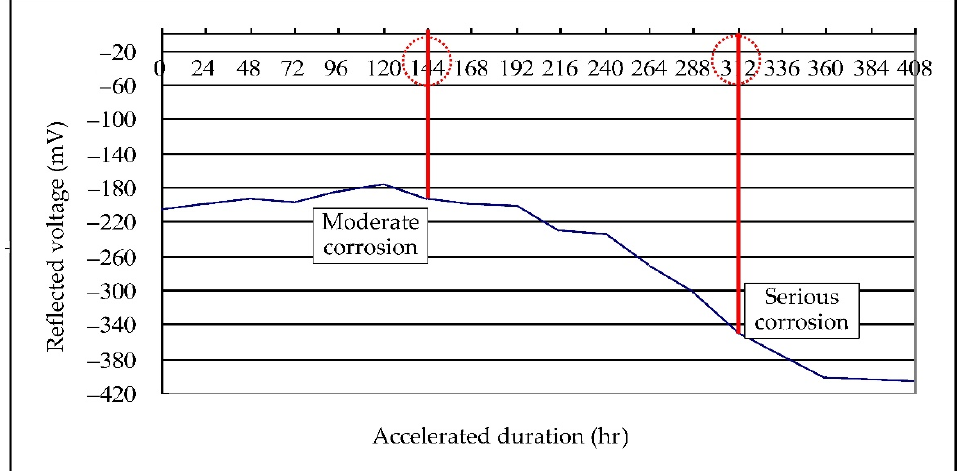
Figure 20. Corrosion Voltage for 9 cm Protective Layer